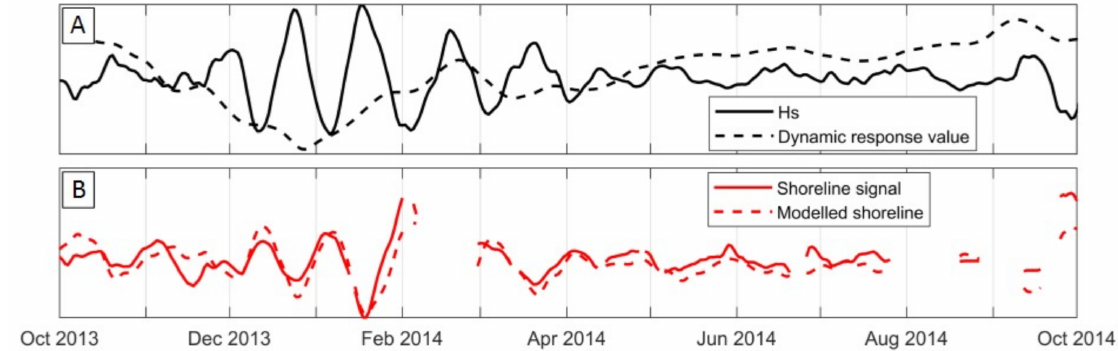
Figure 4. The downscaling approach: modelling the effect of long-term shoreline trends on extreme event impacts. The effect of the larger timescales in shoreline variation on the efficiency with which smaller timescale wave forcing events induce cross-shore sediment transport is modelled (and shown in ( A )) by using a dynamic response factor (black-dashed), which has the shape of the larger timescale shoreline variation signal. ( B ) Shows that if the shoreline on a larger timescale is accreted (e.g., October 2013, high dynamic response factor), the relative (compared to the wave forcing) shoreline response on a smaller timescale is large (higher sediment transport efficiency). Conversely, if it is eroded (e.g., January 2014, low dynamic response factor), the relative shoreline response is low (limited sediment transport efficiency).